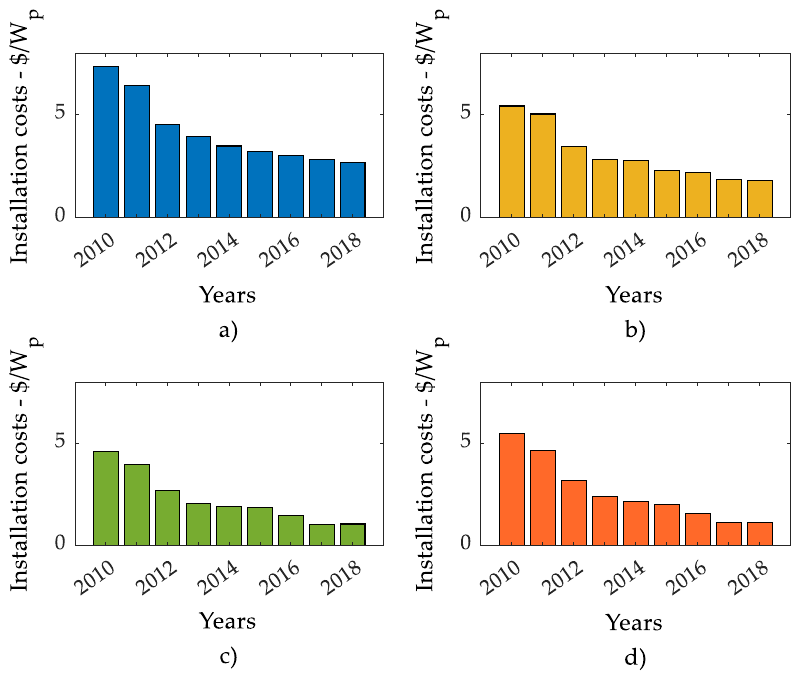
Figure 11. Installation costs for ( a ) residential, ( b ) commercial, ( c ) utility-scale fixed and ( d ) utility-scale tracking photovoltaic system (U.S. market).